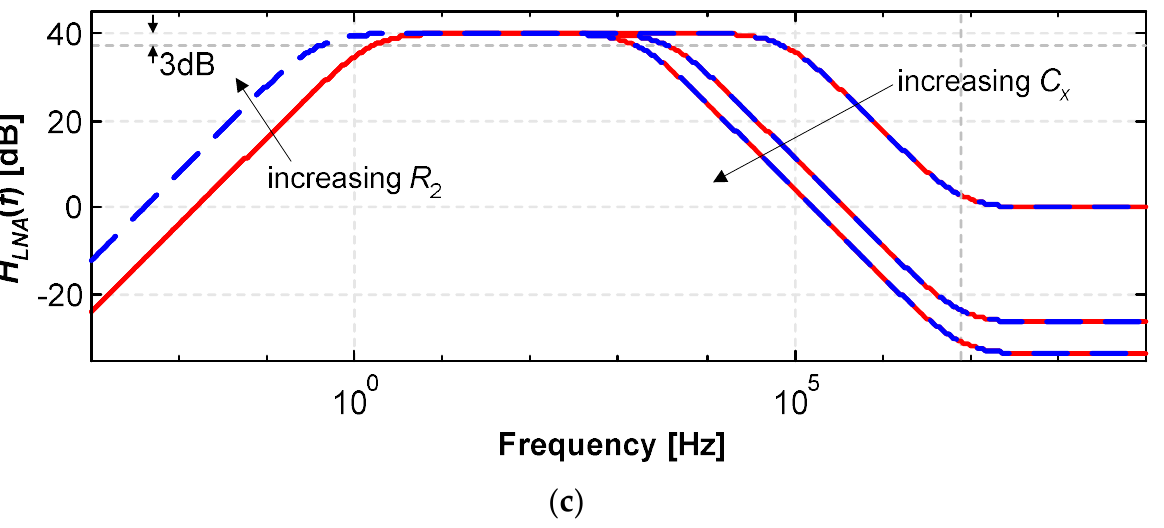
Figure 3. Schematics ( a ) of the low-noise amplifier, highlighting the pseudo-resistors components, and ( b ) of the OTA, showing the currents. ( c ) The transfer function of the LNA for six combinations of R 2 an C x .